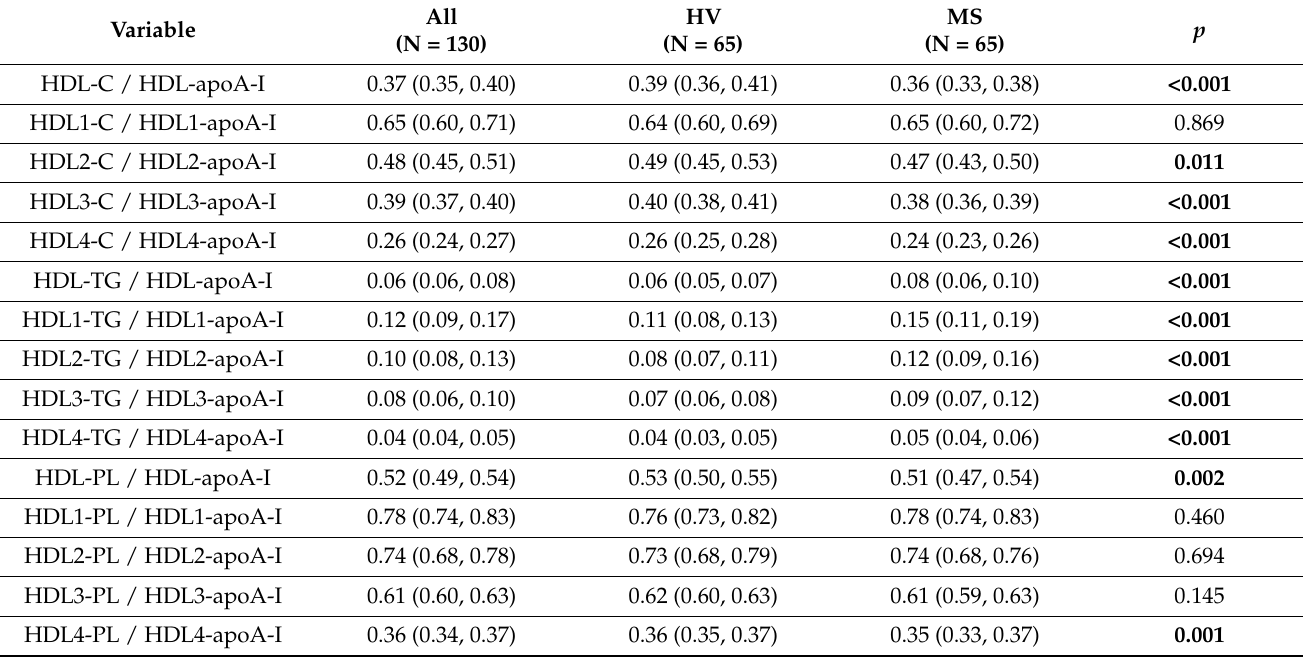
Table 4. Differences in ratios indicating lipid content of HDL particles between HV and MS patients.